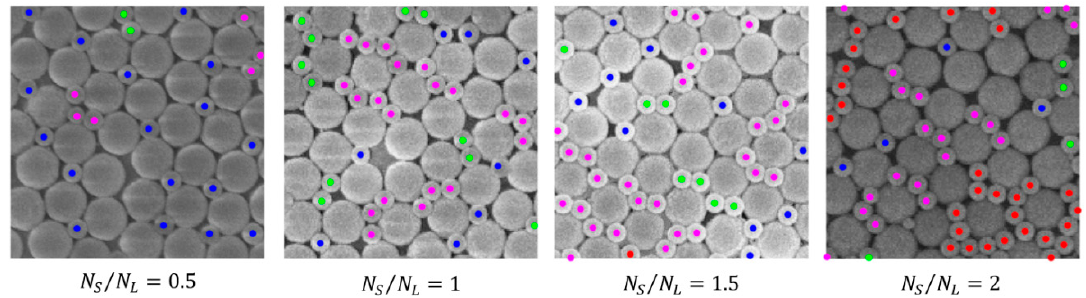
Figure 3. Close-up of binary colloidal assemblies obtained at the air / water interface for variable particle number ratio N S /N L ; a colour-coded representation of S particles according to the defined categories of classification is superposed.